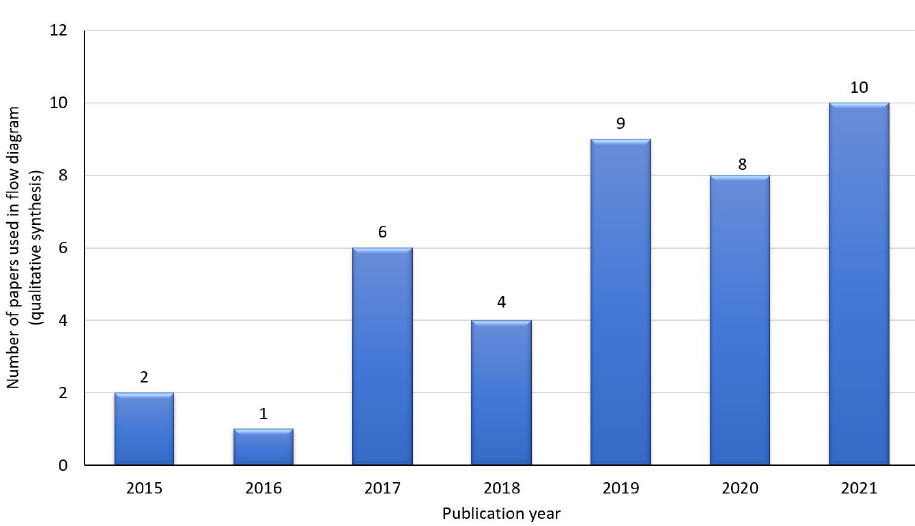
Figure 6. Number of papers used in flow diagram in order to complete qualitative synthesis.